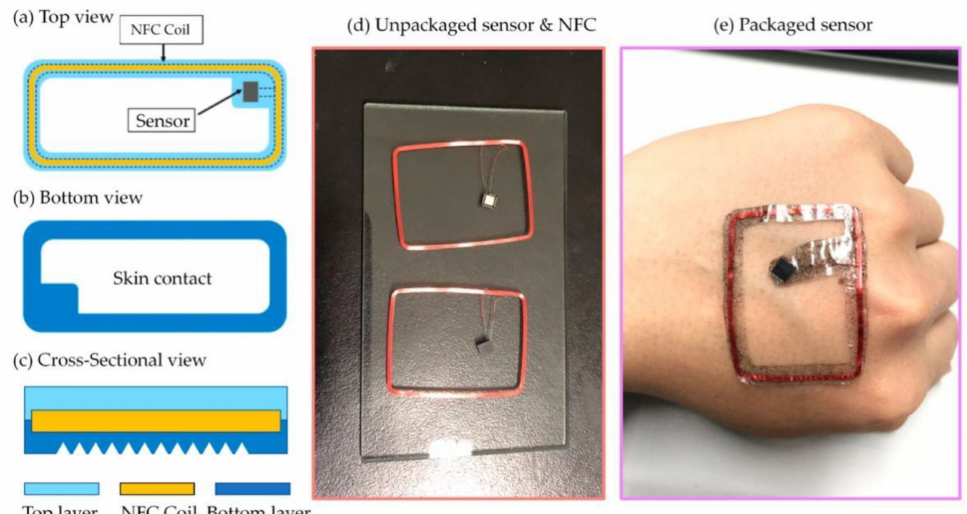
Figure 5. Schematic diagram of the wearable body temperature monitoring device: ( a ) Top view; ( b ) Bottom view; ( c ) Cross-sectional view; ( d ) Unpackaged sensor and NFC copper coil; ( e ) Packaged sensor with graphene-enhanced PDMS layer and its conformal